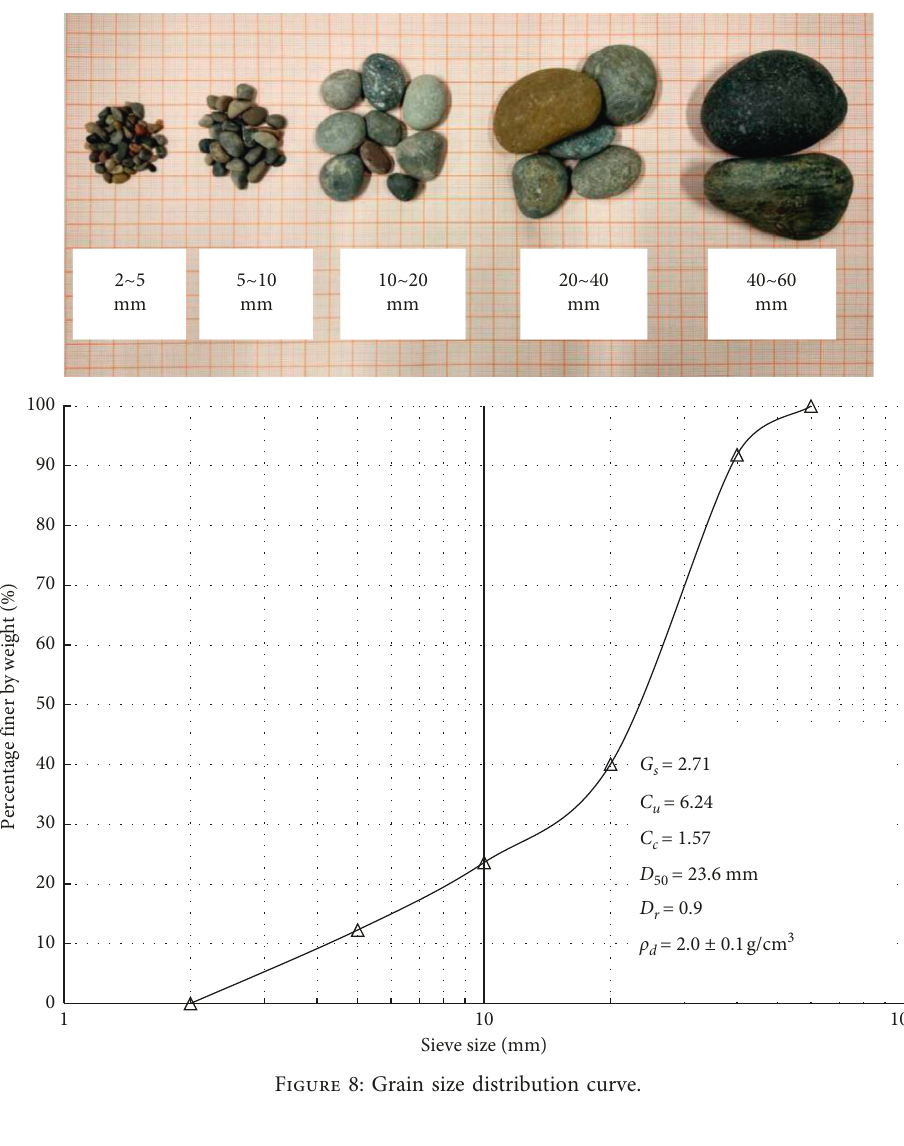
Figure 8: Grain size distribution curve.